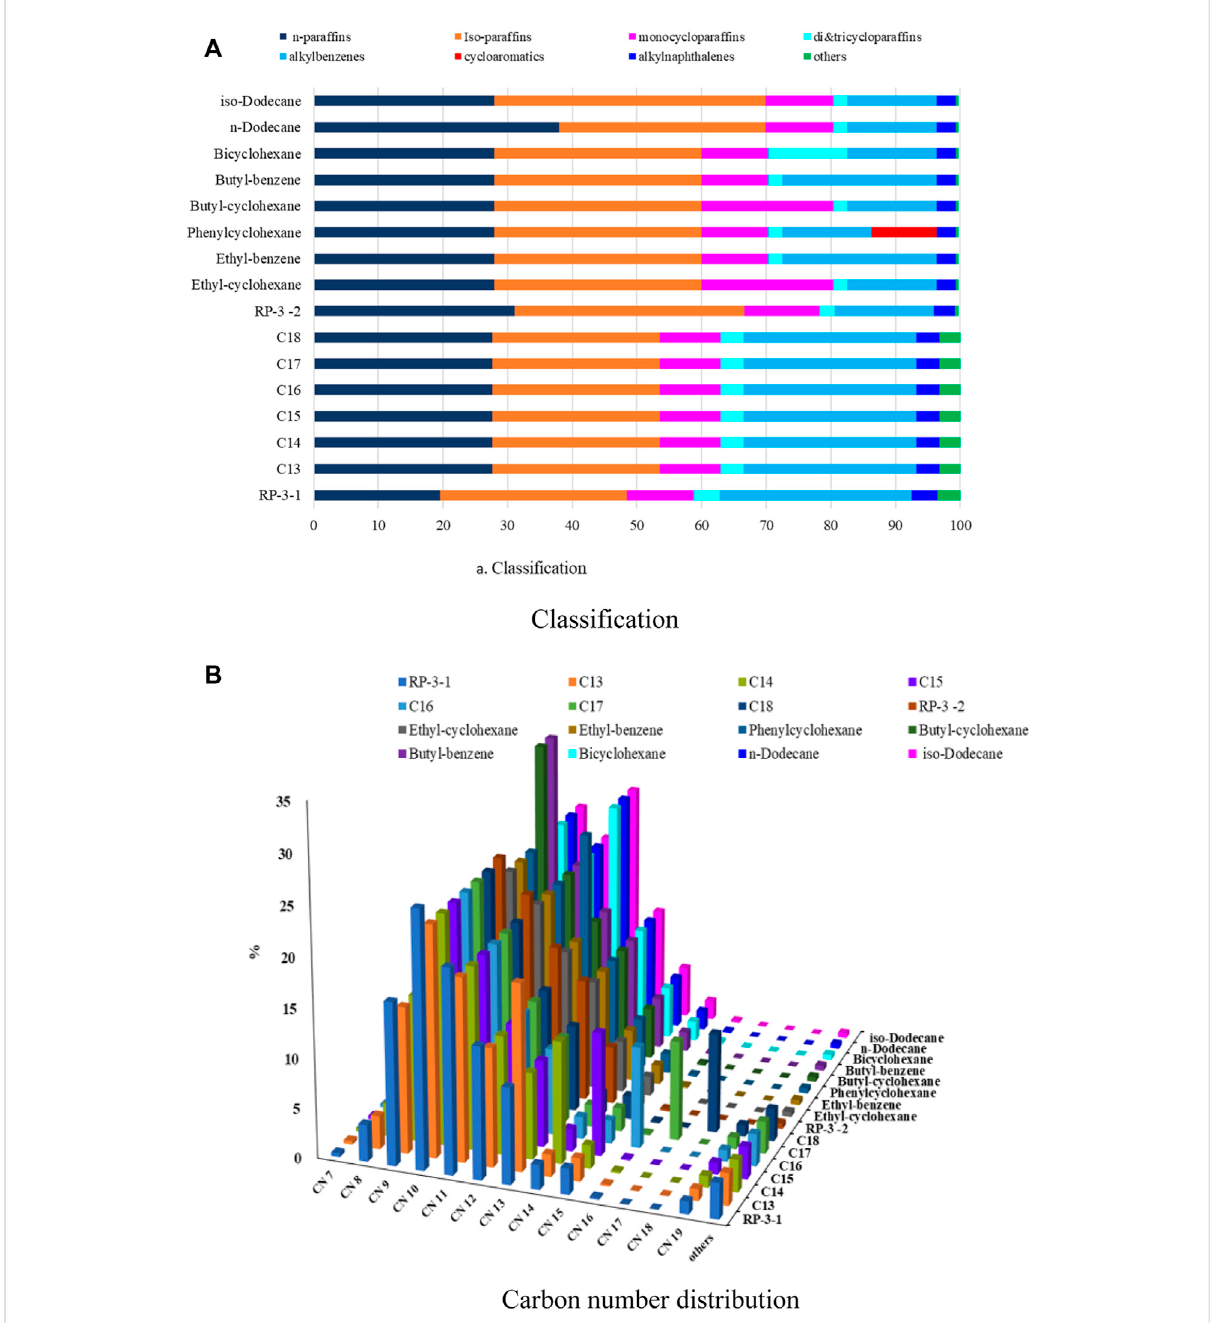
FIGURE 1 Carbon number distribution and classi fi cation of blending fuels. (A) Classi fi cation; (B) carbon number